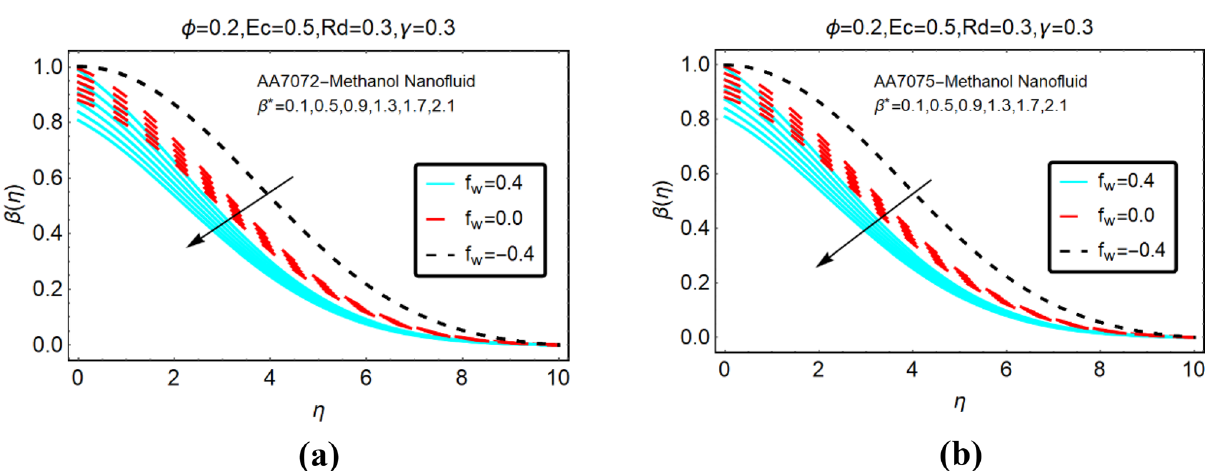
Figure 6. The effects of β ∗ on β(η) ( a ) AA7072-Methanol ( b ) AA7075-Methanol for heat